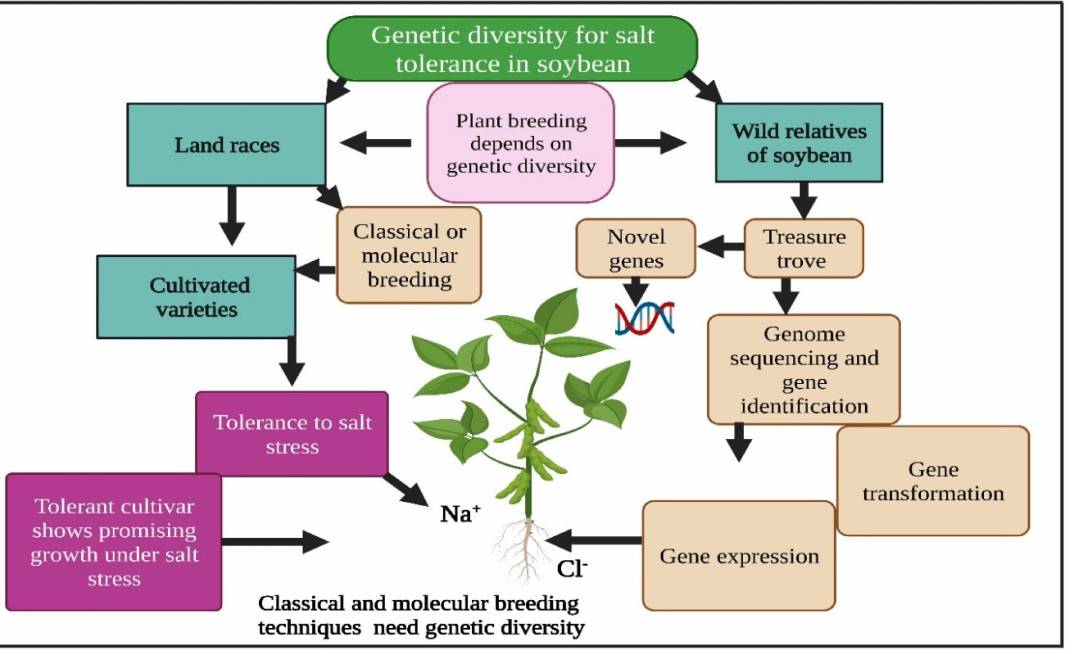
Figure 1. Genetic diversity has a key function in salinity tolerance in soybean. Soybean wild relatives are an important gene source for use in plant breeding programs. This Figure is created with